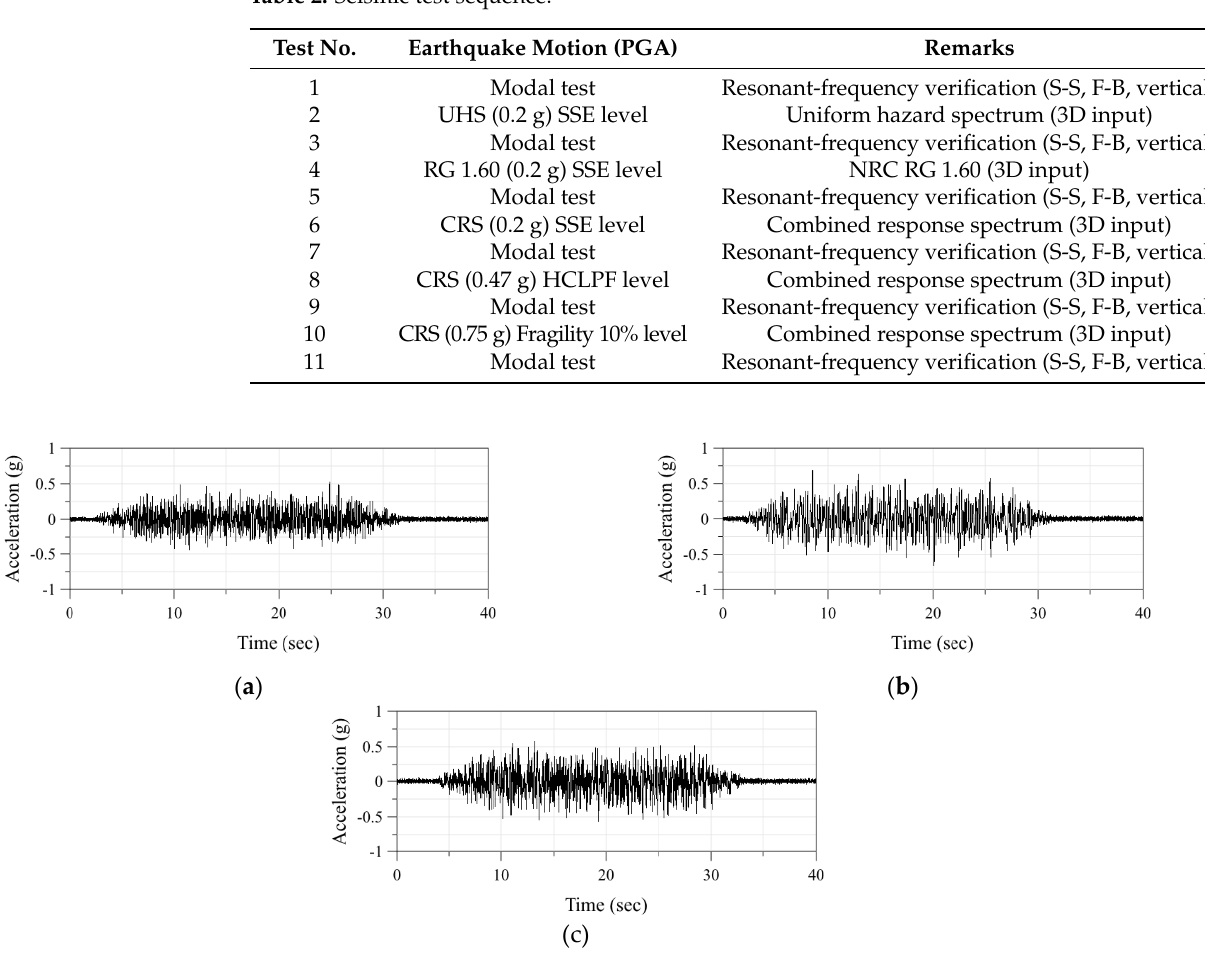
Figure 5. Acceleration time history for front to back depending on input motions: ( a ) uniform hazard spectrum (UHS), ( b ) Regulatory Guide 1.60 design spectrum (RG 1.60), and ( c ) combined response spectrum (CRS).